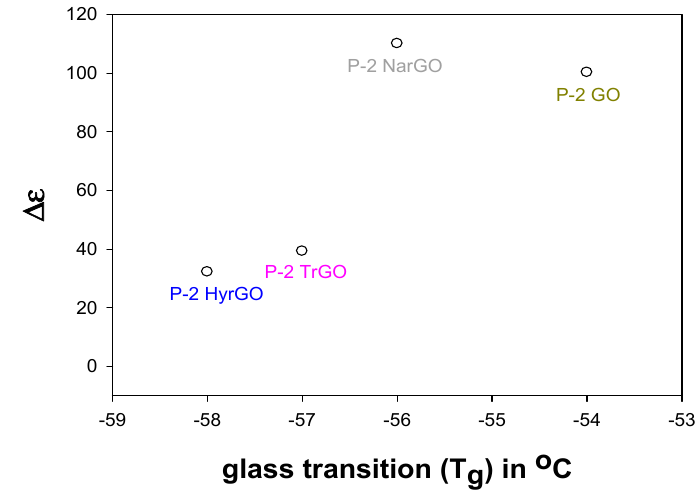
Figure 10. Dependence of dielectric relaxation strength of dielectric interfacial relaxation versus the calorimetric glass transition temperature ( T g ) for PEO composites with 2 wt % GO or rGO. The filler type is indicated with the data points.